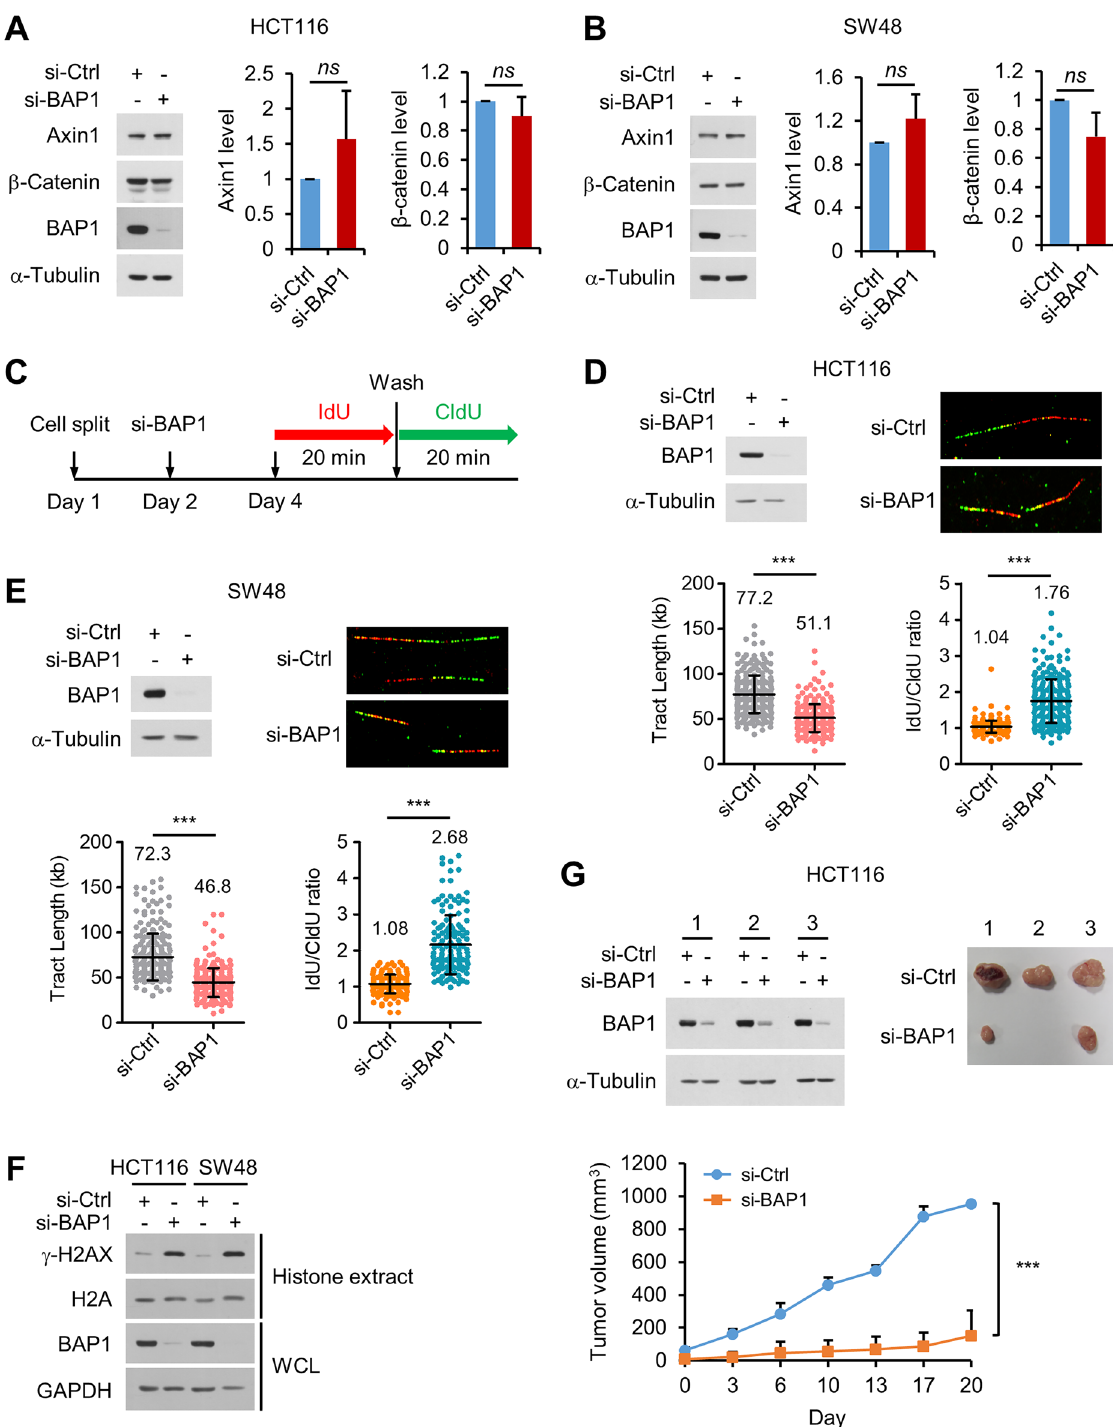
Figure 4. BAP1 depletion induces replication defects in colon cancer cells and inhibits colon tumor growth. ( A , B ) After transfection with control or BAP1 siRNAs, Axin1 and β-catenin expression in HCT116 ( A ) and SW48 cells ( B ) was analyzed by immunoblotting. n = 3; error bars, mean ± s.d. values. ( C ) Experimental scheme. ( D , E ) After transfection with control or BAP1 siRNAs, HCT116 ( D ) and SW48 cells ( E ) were subjected to a DNA fiber assay. (Upper left) Immunoblot analysis of BAP1 knockdown. (Upper right) Representative images of DNA fibers. (Lower left) Summary of the IdU and CldU track lengths. Fiber counts for the scatter plot: si-Ctrl = 265, si-BAP1 = 228 for HCT116; si-Ctrl = 198, si-BAP1 = 248 for SW48. (Lower right) Summary of the IdU/CldU ratio. Fiber counts for the scatter plot: si-Ctrl = 229, si-BAP1 = 250 for HCT116; si-Ctrl = 168, si-BAP1 = 152 for SW48. ( F ) After BAP1 knockdown, cells were divided into two groups for preparation of whole-cell lysates (WCLs) and histone extracts for immunoblotting. Representative data from three similar results are shown. ( G ) Results of the xenograft experiment showing that BAP1 knockdown inhibited the tumorigenic growth of HCT116 cells. (Upper left) Results of immunoblot analysis of BAP1 knockdown in three separate experiments. (Upper right) Images of the tumors excised from mice. (Bottom) Summary graph. n = 3; error bars, mean ± s.d.